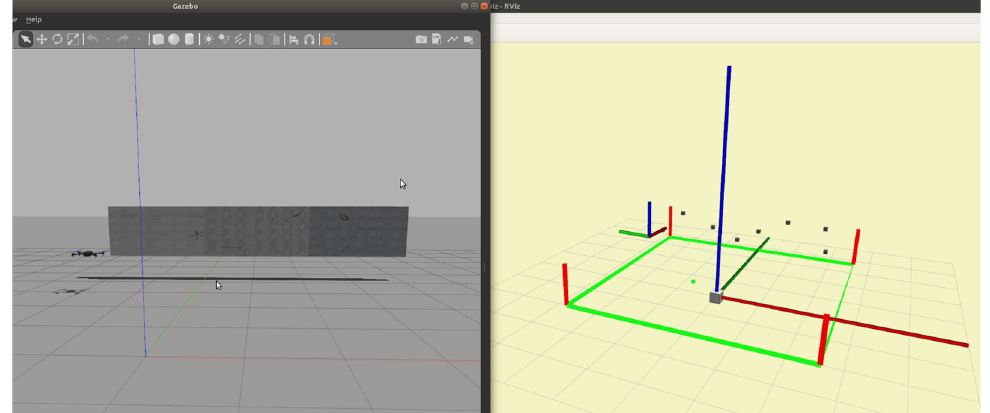
Figure 10. The simulation in Gazebo ( left ) and RViz ( right ) simultaneously.